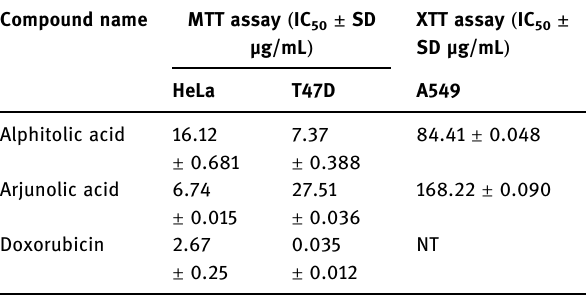
Table 3: Anticancer activity against HeLa, T47D, and A549 cell lines Compound